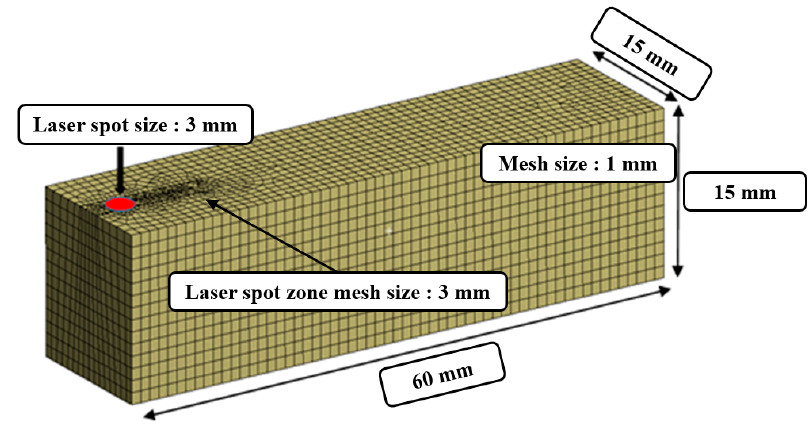
Figure 3. The finite element analysis model. Table 2. The main components of C / SiC composite.